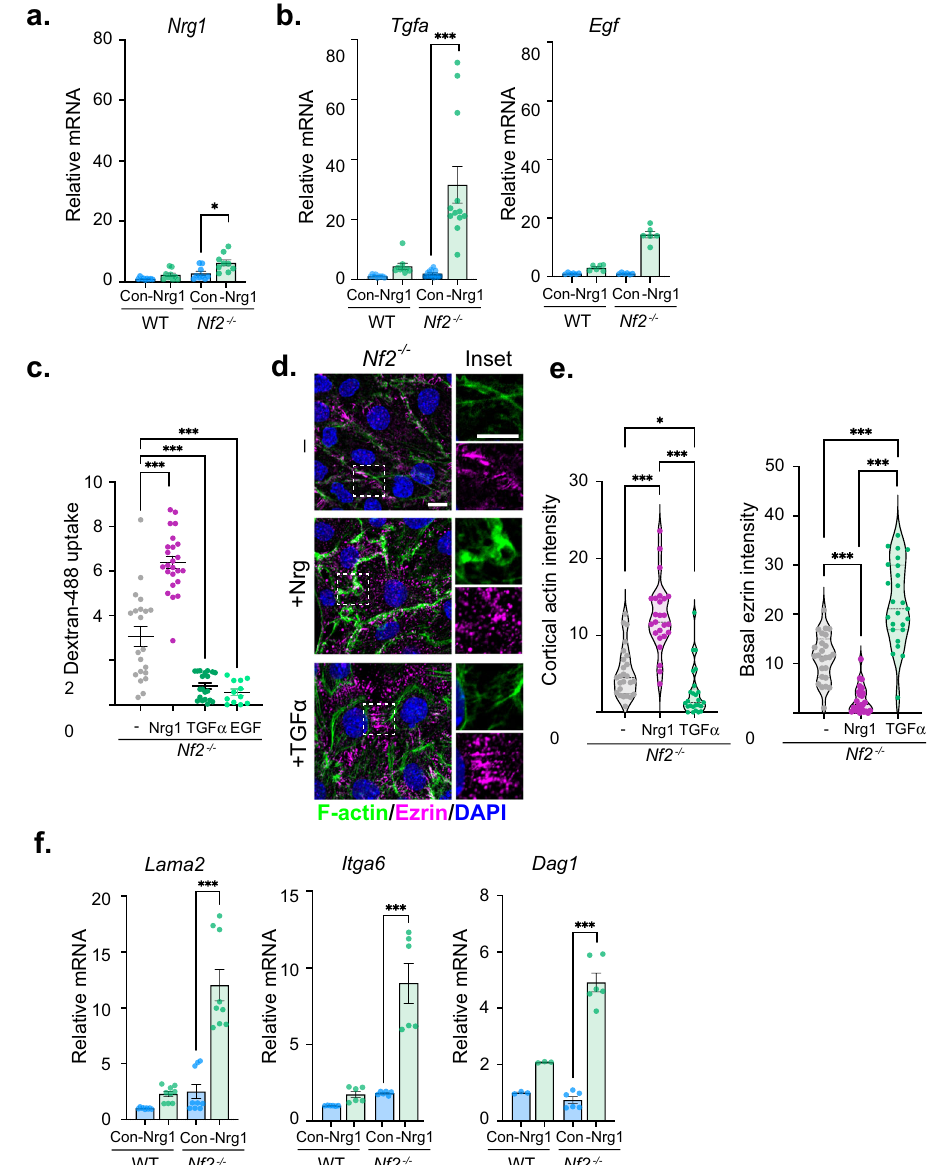
Fig. 3 | Nf2 − / − SCs upregulate basal polarity components upon Nrg1 − depriva- tion. a Levels of Nrg1 mRNA in WT and Nf2 − / − SCs grown in complete medium (control; Con) or deprived of Nrg1 for 24h. Data are presented as mean±SEM relative to WT mRNA levels. n =3 replicates. b Levels of Tgfa and Egf mRNA in WT and Nf2 − / − SCsgrownundercompletemediumordeprivedofNrg1for24h.Dataare presented as mean±SEM relative to WT mRNA levels for n =3, N =3 independent experiments (WT, Tgfa ); N =4 independent experiments ( Nf2 − / − ; Tgfa ); N =2 inde- pendent experiments (WT, Nf2 − / − , Egf ). c Quantitation of macropinocytic dextran- 488 uptake in Nf2 − / − SCs starved of Nrg1 overnight and stimulated with 10ng/ml Nrg1,TGF α ,orEGF. n =18(starved), n =20(Nrg1), n =16(TGF α ),or n =8(EGF)cells